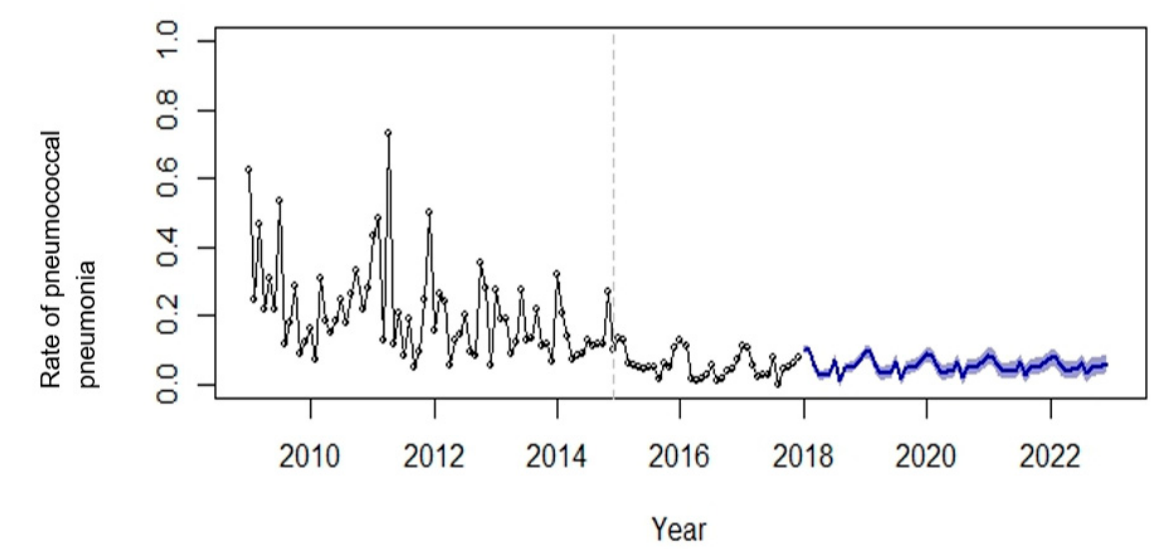
Figure 2. Monthly rate of pneumococcal pneumonia among hospitalised adults at PWH (2009–2017) and projected rates of pneumococcal pneumonia (2018–2022) using SARIMA time series model. Black points represent rates of pneumococcal pneumonia calculated from historical data. Dark blue lines represent projected rates of pneumococcal pneumonia for the following five years. The light blue region represents a 50% confidence interval of the projected rate. The grey dashed line indicates recommendation of PCV13 for high risk adults in Hong Kong (December